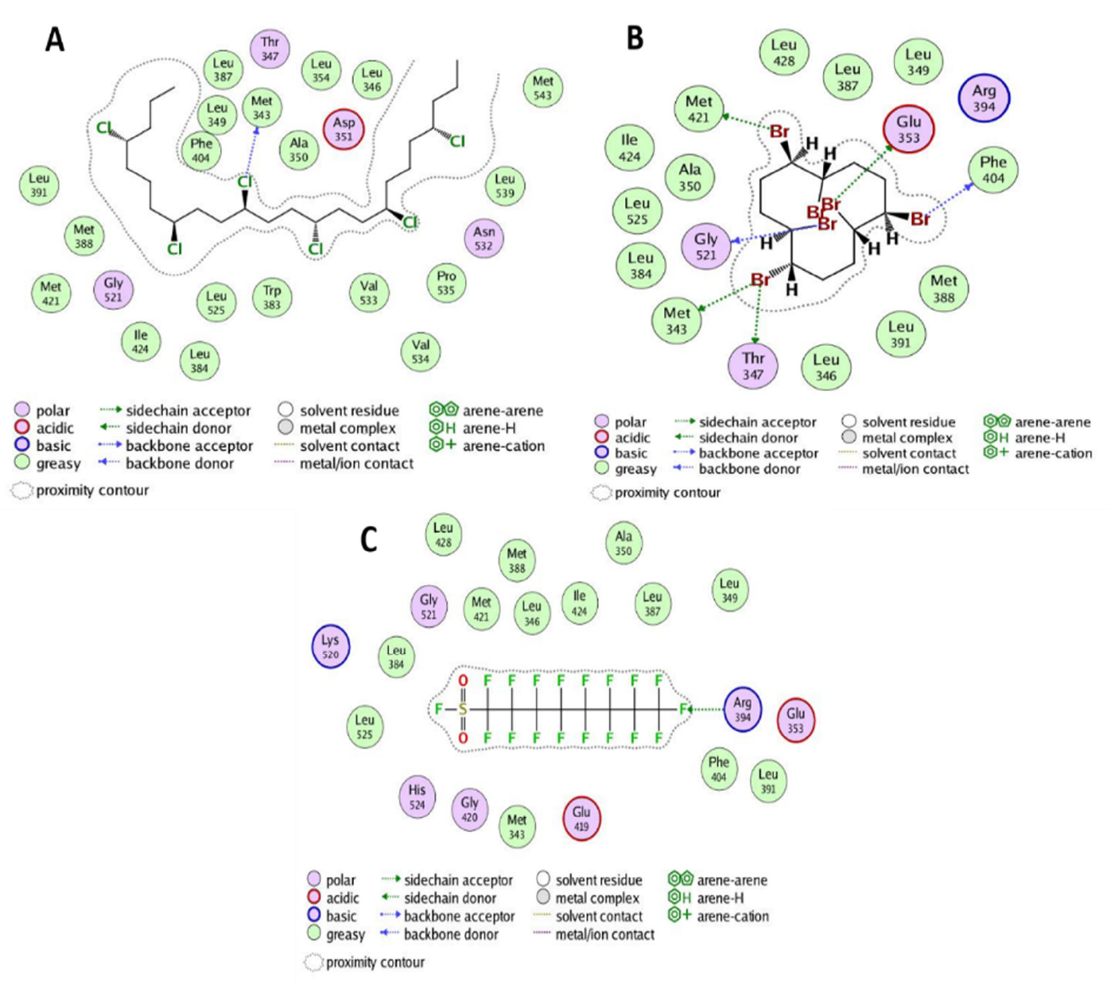
Figure 1. Two dimensional interactions of short chain chlorinated paraffins ( A ), Hexabromocyclododecane ( B ) and Perfluorooctanesulfonyl fluoride ( C ) with ER α protein of Breast Cancer.